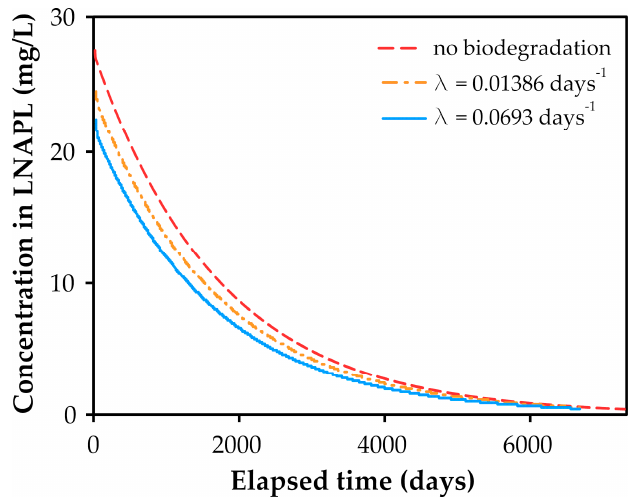
Figure 8. The benzene concentration decreases with different biodegradation rates in the aqueous phase.